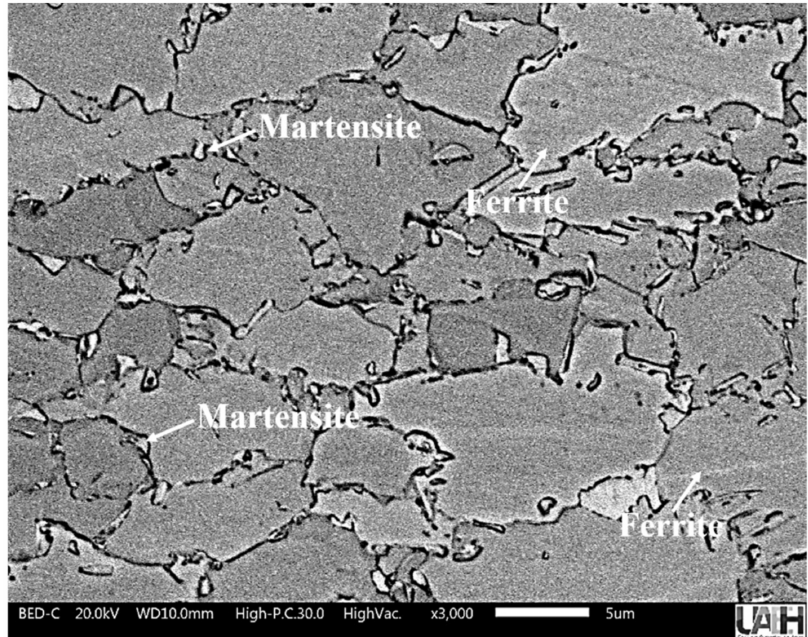
Figure 7. DP steel microstructure obtained by means of SEM. During the impact, the energy supplied was not enough to fracture the material and the welding. Figure 8 shows the strain vs. time behavior obtained from the LC and DP impact test. It can be seen that a maximum strain (23.3 µ ε ) is generated at 3.04 ms in LC steel, and DP steel presents the highest strain (30. 3 µ ε ) at 2.48 ms.